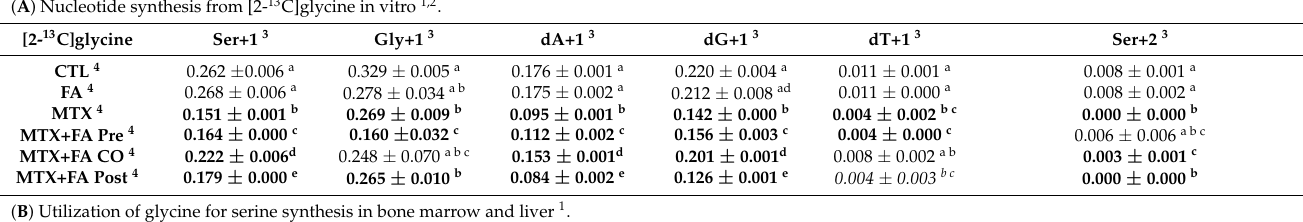
Table 5. Methotrexate (MTX) significantly inhibits formate production via mitochondrial glycine cleavage system (GCS) that can be rescued by folinate in vitro and in